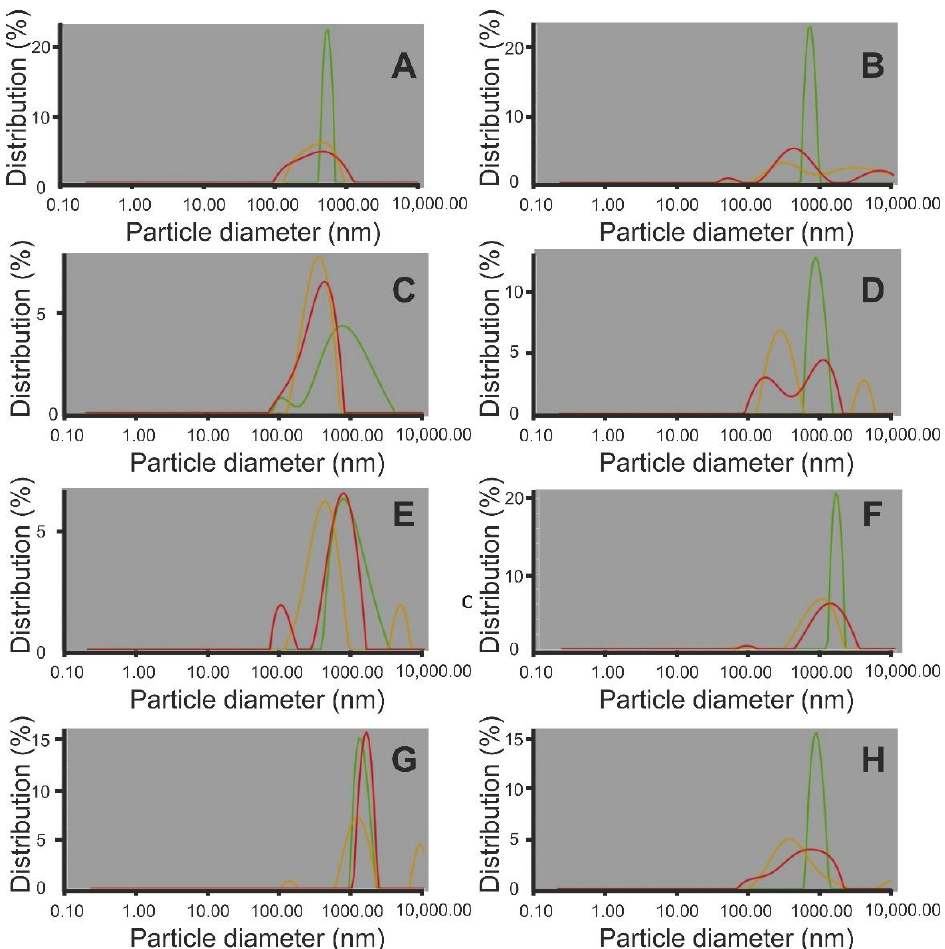
Figure 3. Particle size distribution in the tested calcium matrices. Green series—measured at an angle of 15°, yellow series—measured at an angle of 90°, red series—measured at an angle of 175°). ( A ) EGR, ( B ) EHSI, ( C ) ELI, ( D ) ELA, ( E ) ED, ( F ) ECM, ( G ) EK, ( H ) EC.